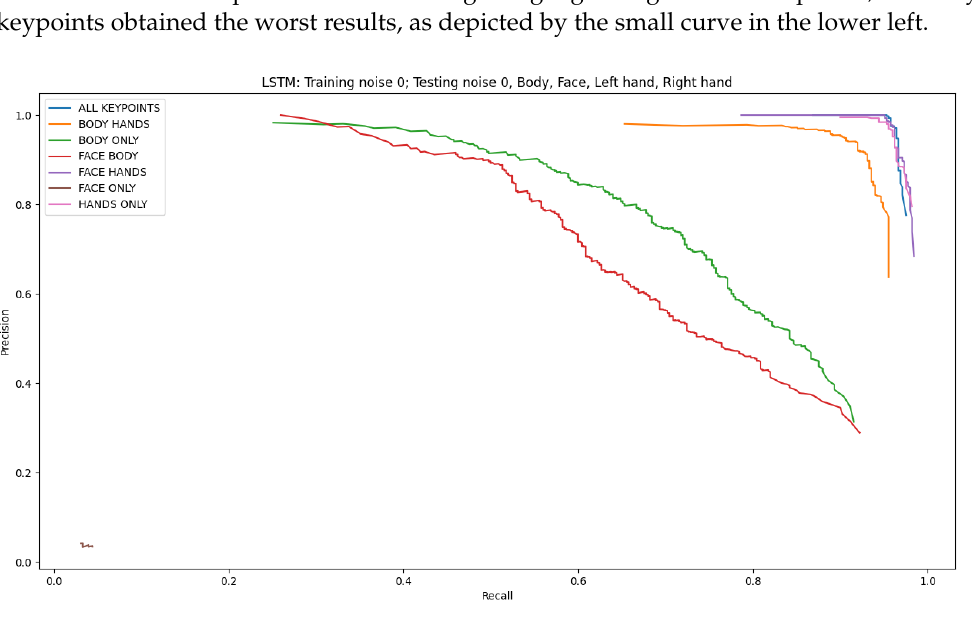
Figure 8. Precision recall curves for features